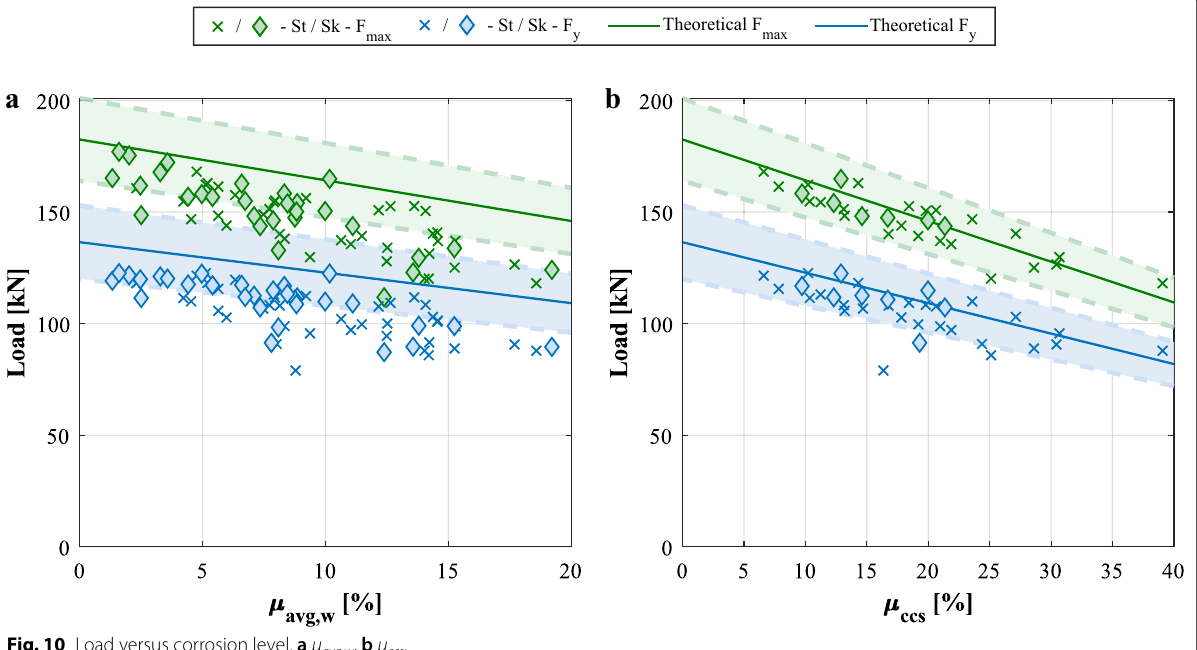
Fig. 10 Load versus corrosion level. a μ avg,w , b μ ccs